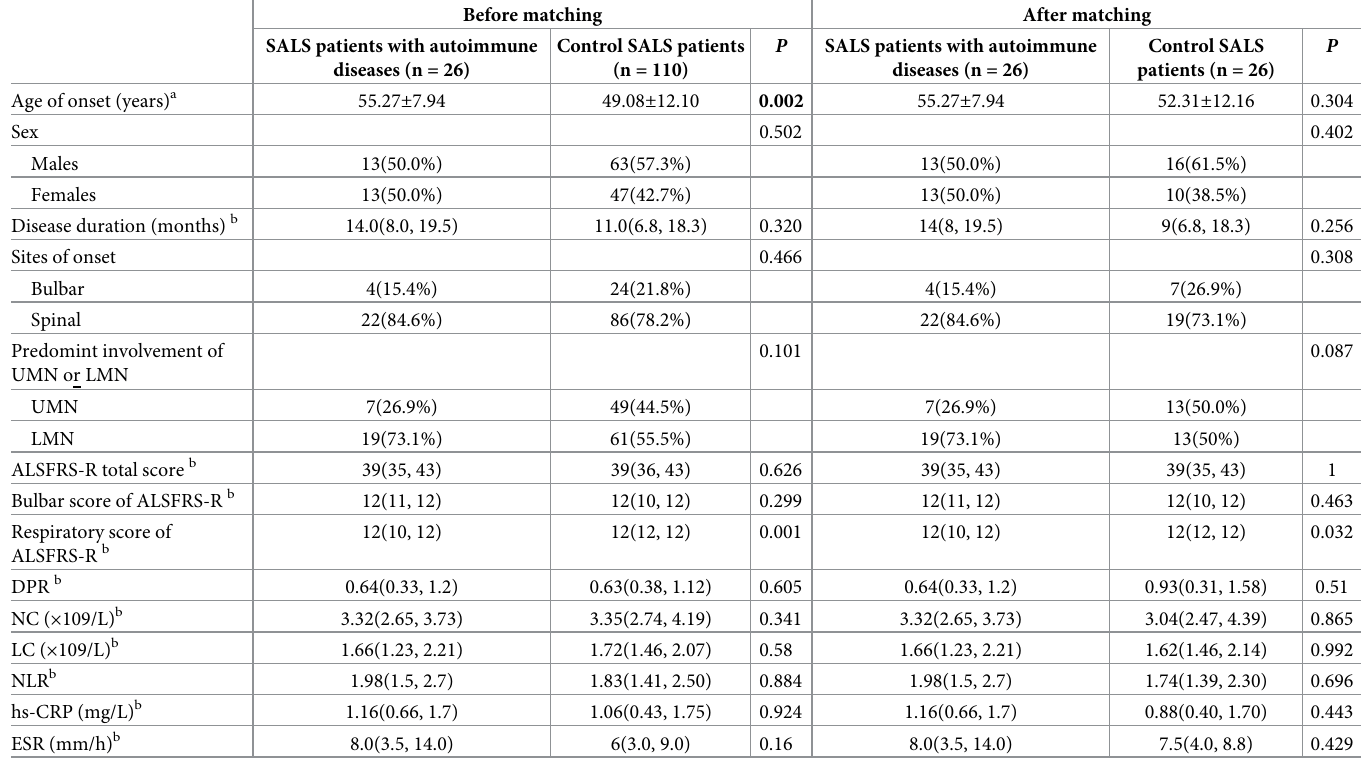
Table 2. Clinical characteristics and serum inflammatory biomarkers of ALS patients and